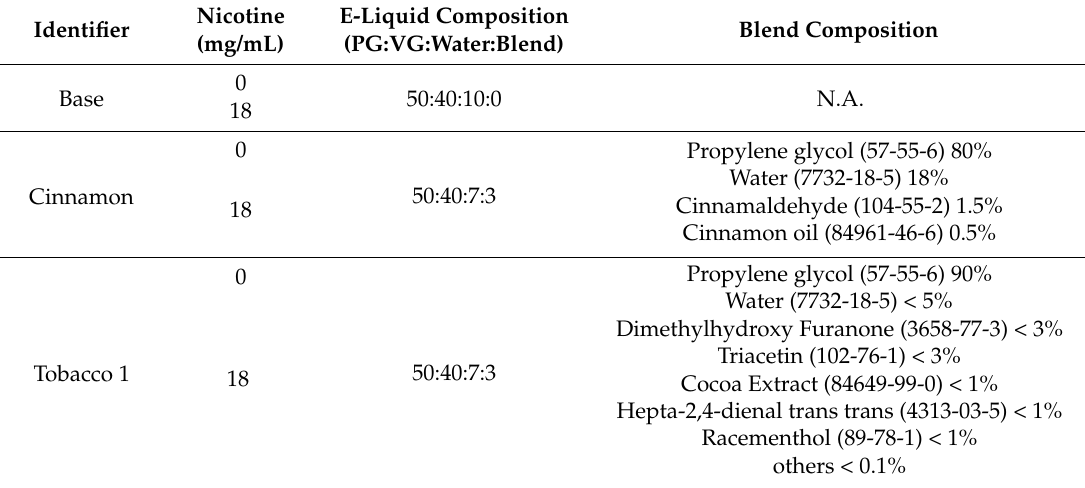
Table 1. Composition of the tested e-liquids. For each sample, both no and 18mg/mL nicotine were analysed. PG: pharma grade propylene glycol, VG: vegetable